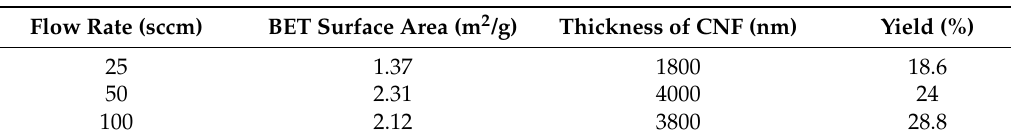
Table 4. Effect of hydrocarbon flow rate on CNF growth by use of 100 mM catalyst concentration under 550 °C for 30 min (on 0.5 g CF).